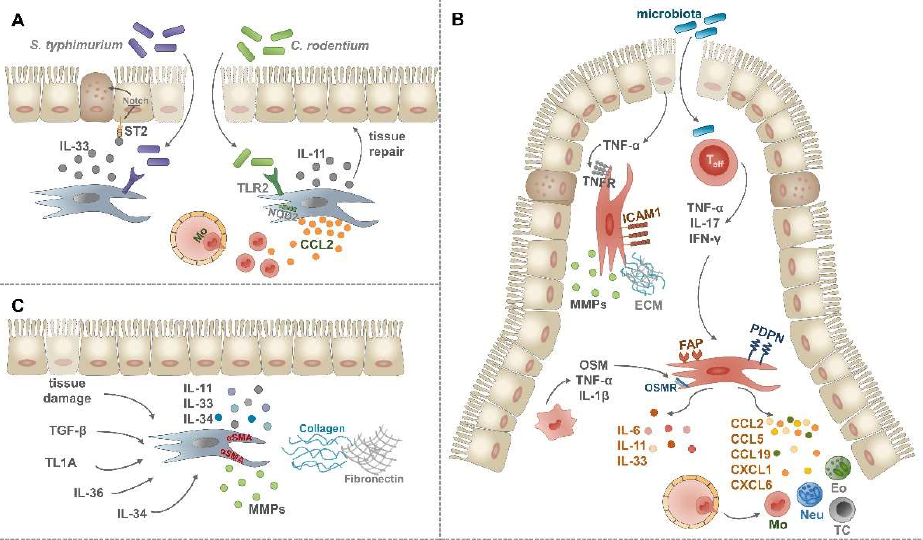
Figure 2. Role of IMCs upon intestinal inflammatory conditions. ( A ) Following infection with C. rodentium or S. typhimurium IMCs become activated. By the production of IL-11 and IL-33 pro-fibrogenic cytokines and CCL2 chemokine, they actively support tissue repair and the recruitment of inflammatory monocytes. ( B ) Fibrosis can be induced by dysregulated wound healing and a number of secreted factors, such as transforming growth factor-β (TGF-β), TL1A, IL-36, and IL-34. These mediators drive the accumulation and differentiation of αSMA + myofibroblasts which then secrete excess ECM molecules and pro-fibrogenic cytokines. ( C ) Upon IBD, fibroblasts can be activated by TNF-α of epithelial origin, leading to their increased ICAM-1 expression and fibrogenic potential. Activated T cells can serve as another source of pro-inflammatory cytokines, such as TNF-α, IL-17, and IFN-γ, driving fibroblast activation. As a response, activated fibroblasts secrete pro-inflammatory and pro-fibrogenic cytokines, a vast array of chemokines, upregulate the expression of FAP and podoplanin and interact with macrophages via the OSM-OSMR axis.